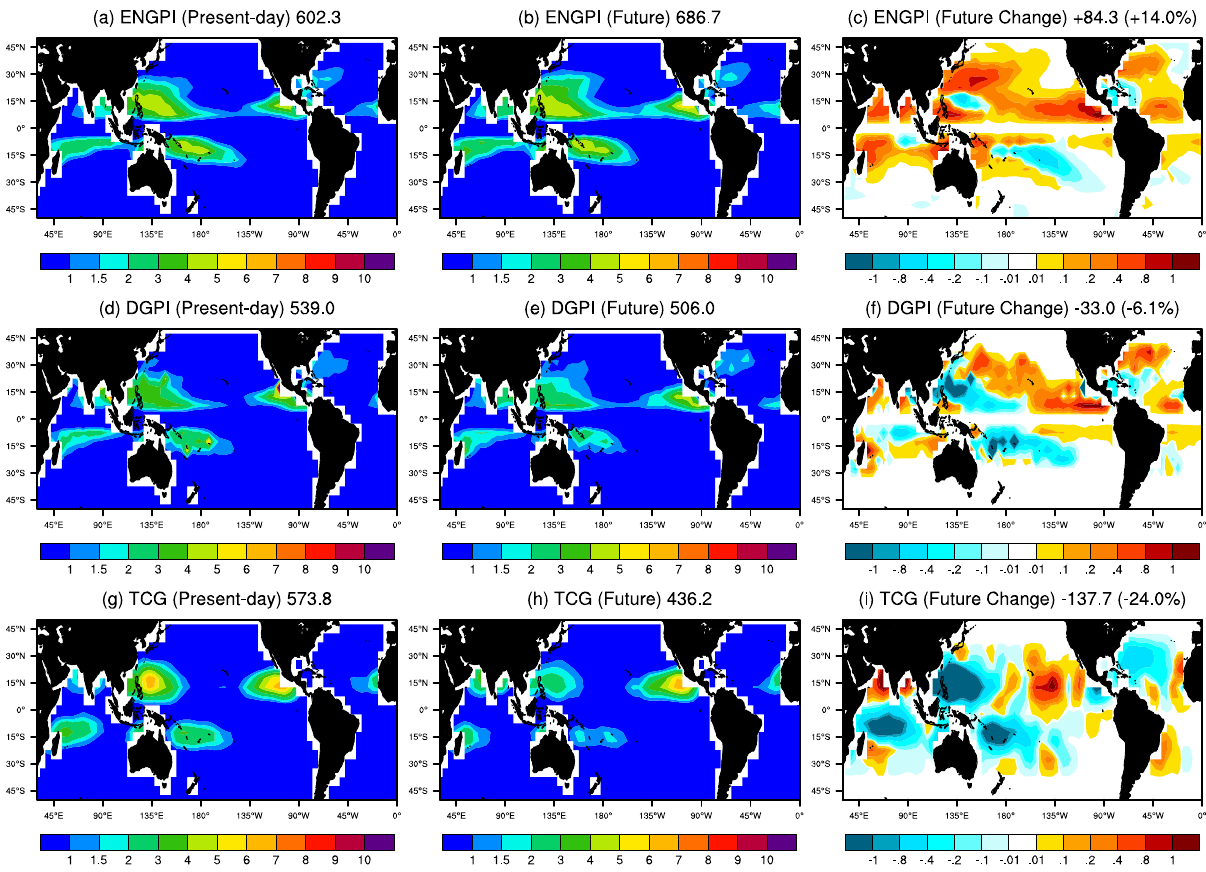
Fig. 2 Projected future changes in GPI and TCG frequency by MRI-AGCM3.2S. The results are from the 20-km resolution MRI-AGCM3.2 under the present-day climate (1979 − 2003) and high-emission RCP8.5 future scenario of CMIP5 (2075 − 2099): a ENGPI in the present-day simulation (1979 − 2003); b ENGPI in the future projection (2075 − 2099); c projected future changes in ENGPI. d – f As in a – c but for DGPI. g – i As in a – c but for the model-projected TCG frequency. The numbers in the titles indicate total TCG and GPIs, whereas the numbers in brackets indicate the fractional changes in future